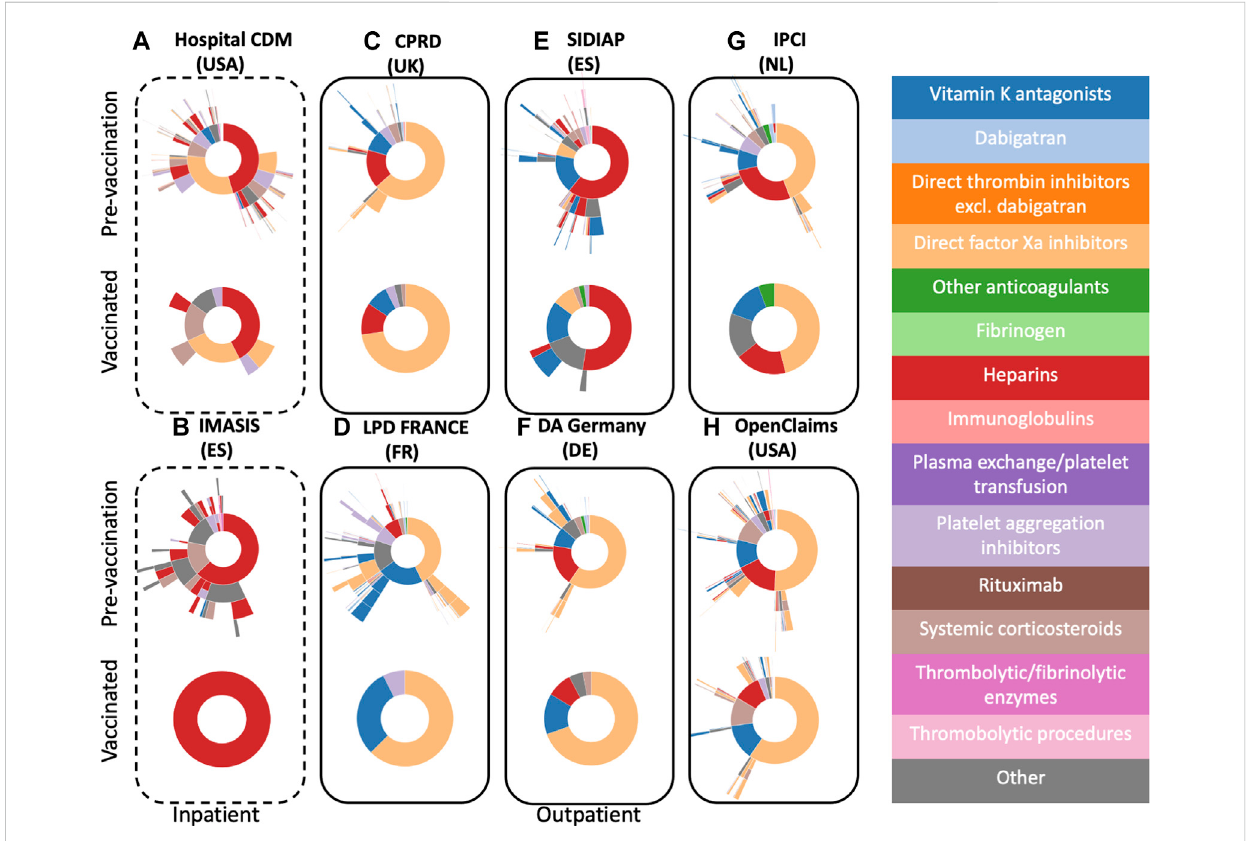
FIGURE 2 Sunburst plots visualizing treatment pathways for VTE patients in pre-vaccination cohorts (top) versus vaccinated cohorts (bottom). Inpatient databases are depicted with a dashed line frame, whilst outpatient ones have a solid